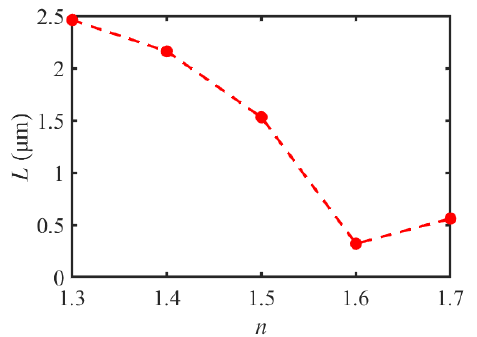
Figure 5. Comparison of the propagation distance L of the SPP − PNJ with different dielectric micro- disk refractive indices n .